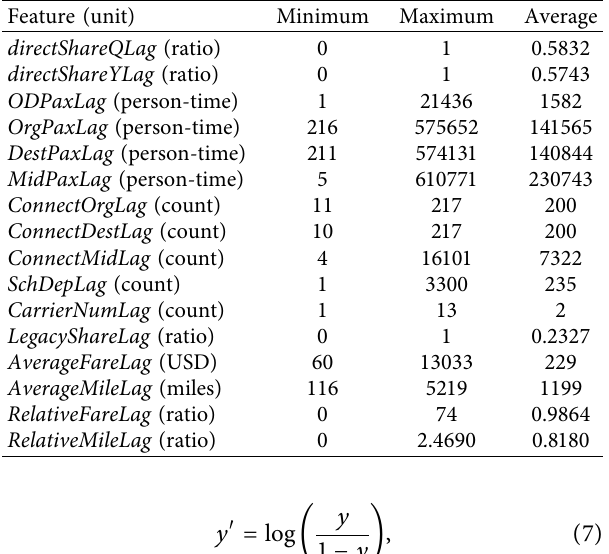
Table 2: Basic analysis of important